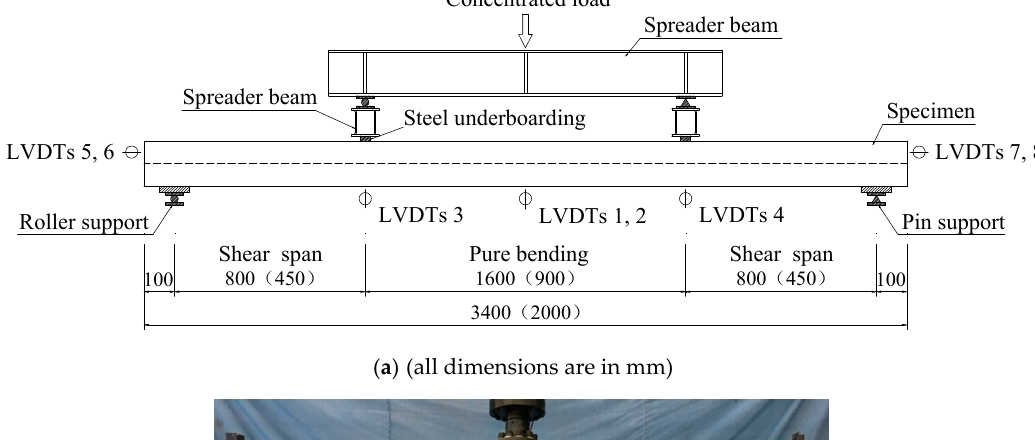
Figure 6. Location of linear variable displacement transducers (LVDTs) and strain gauges of profiled steel sheeting (all dimensions are in mm).